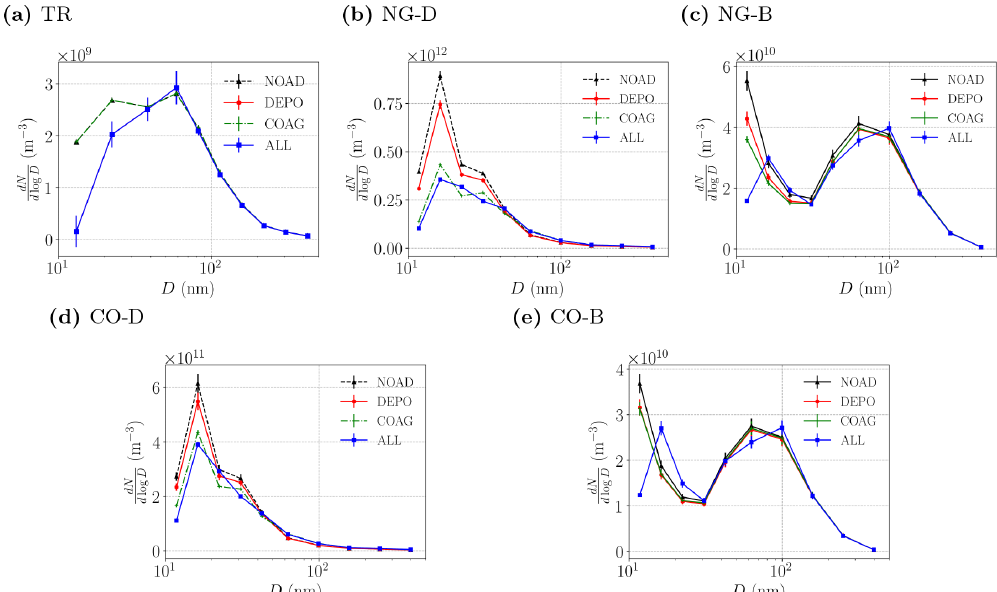
Figure 12. Canyon-averaged aerosol number size distributions for different emission scenarios: (a) traffic; (b) near-ground deep-frying; (c) near-ground boiling; (d) column deep-frying; (e) column boiling. Each line corresponds to a different set of aerosol processes (see Fig. 9 for definitions). The standard error (obtained from the temporal standard deviation) is denoted by the error bars.